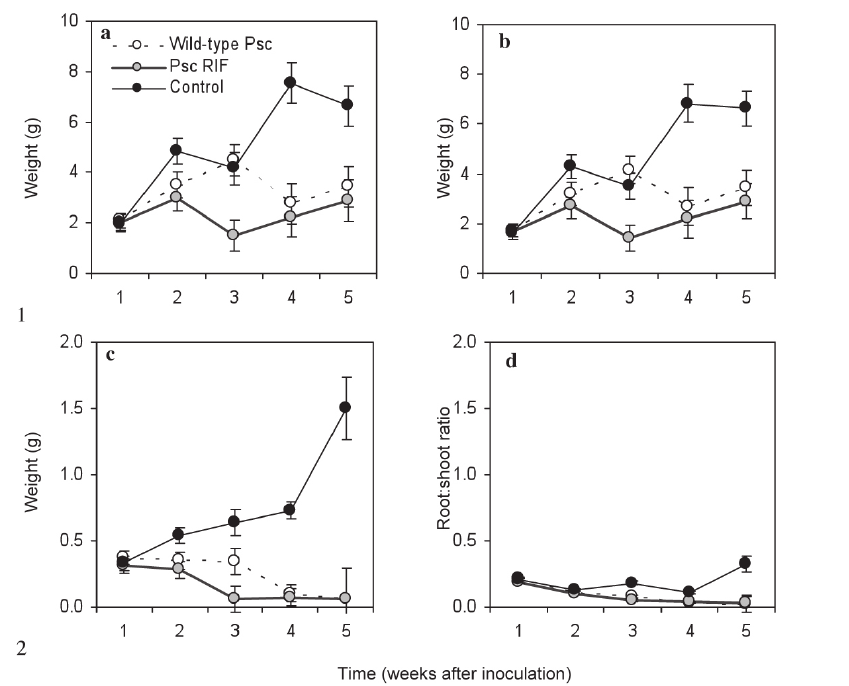
Figure 1. Effect of coriander blight on a) total plant dry weight, b) shoot dry weight, c) root dry weight, and d) root- shoot ratios of fortnight-old seedlings inoculated with wild-type Pseudomonas syringae pv. c oriandricola (Psc) , Psc rif and an uninoculated control. Standard errors of the means are